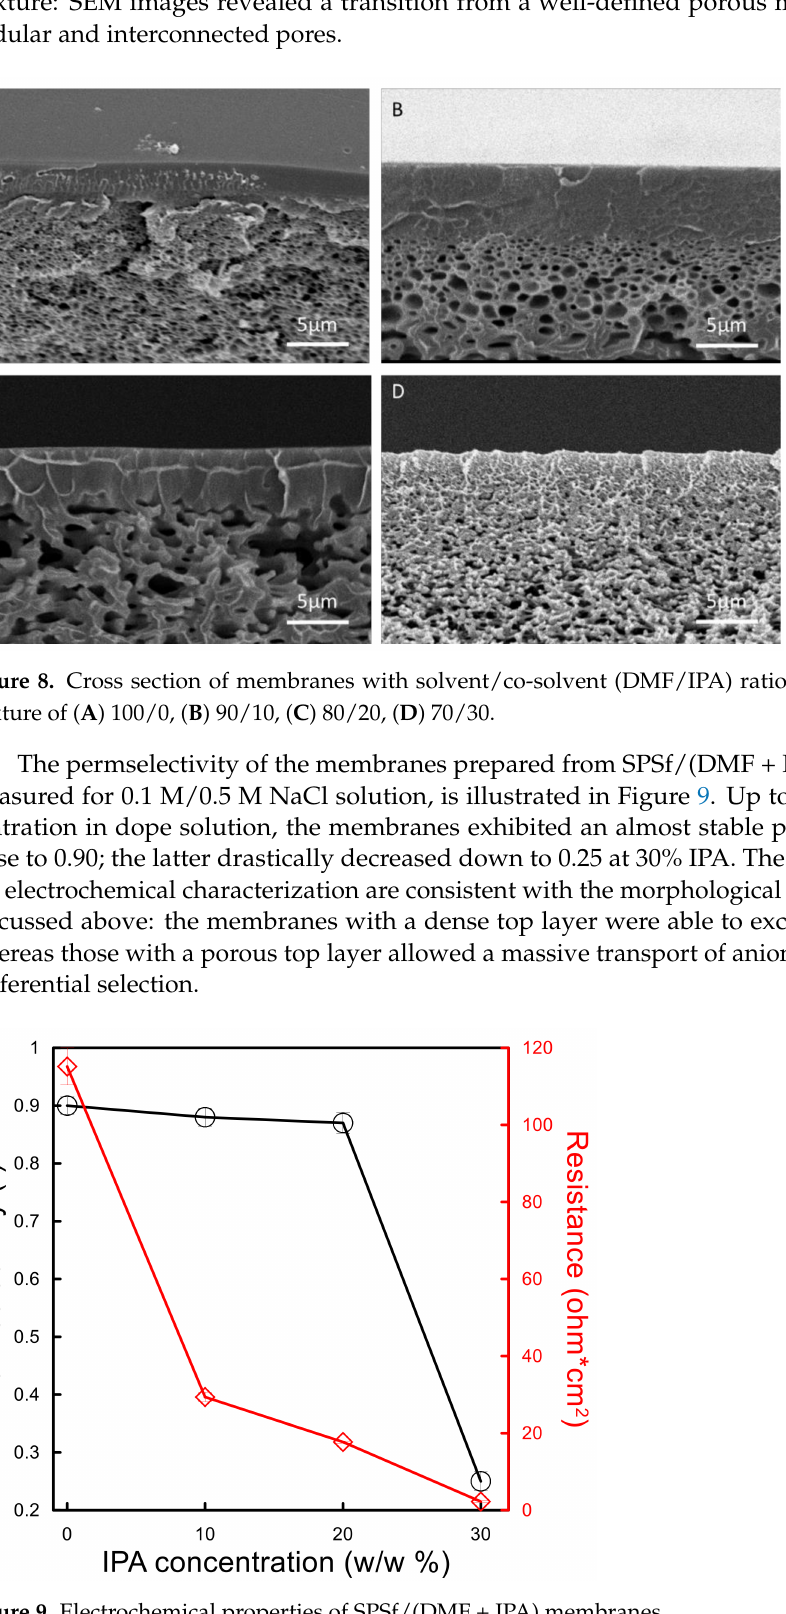
Figure 9. Electrochemical properties of SPSf/(DMF + IPA)